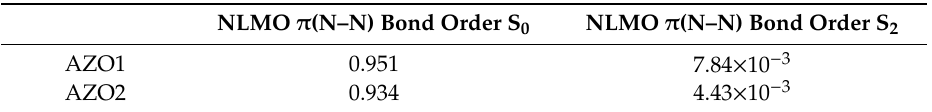
Table 8. NLMO bond orders in the two states S 0 and S 2 at the ground state CASCI (4,3) / def2-TZVP level.